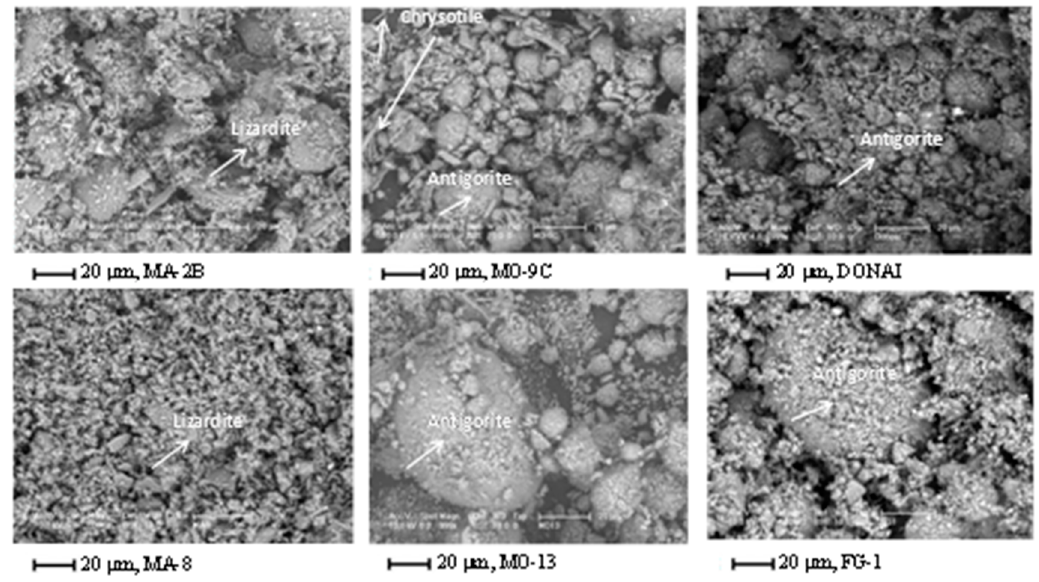
Figure 2. Scanning electron microscopy micrographs of serpentinites.